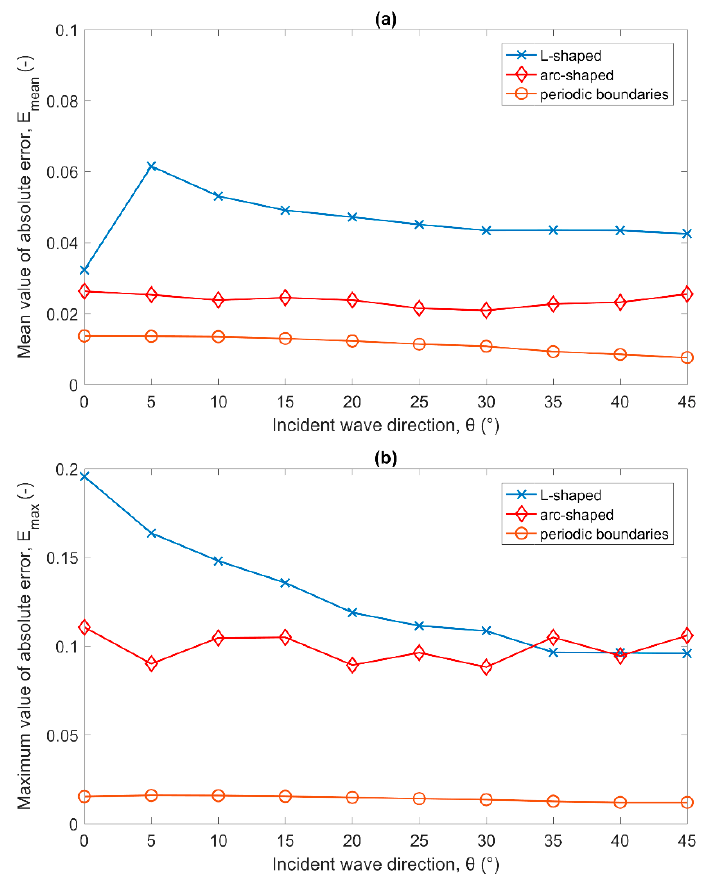
Figure 6. ( a ) Mean (E mean ) and ( b ) maximum (E max ) value of the absolute errors calculated using Equation (22) for each wave generation layout for a range of different incident wave angles, θ .